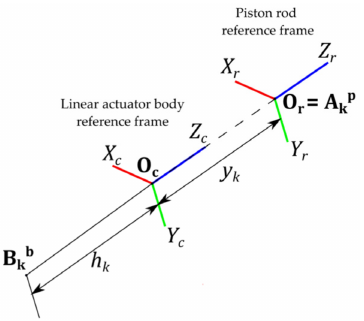
Figure 5. Detail on the linear actuator reference